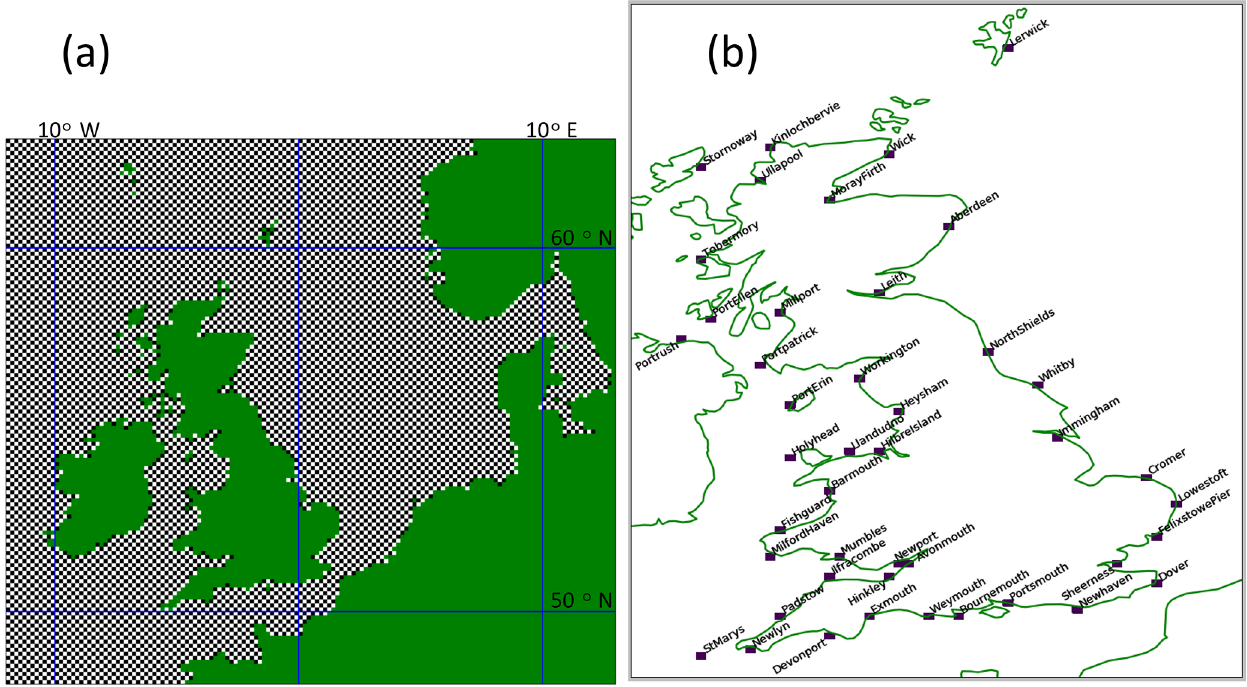
Figure A1. (a) Domain and grid of the CS3 coastal shelf model. Grid size is 1 / 9 ◦ in latitude and 1 / 6 ◦ in longitude, which results in near-square grid cells at the latitude of the UK. (b) Tide gauge